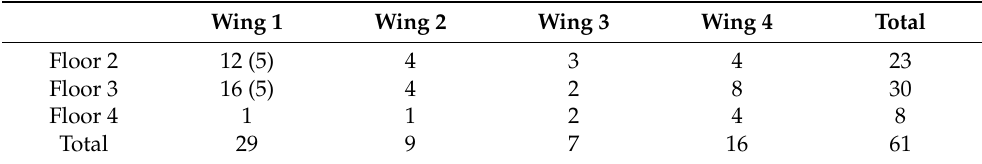
Table 2. Number of respondents per floor and wing—within parenthesis: the respondents who were inquired twice.